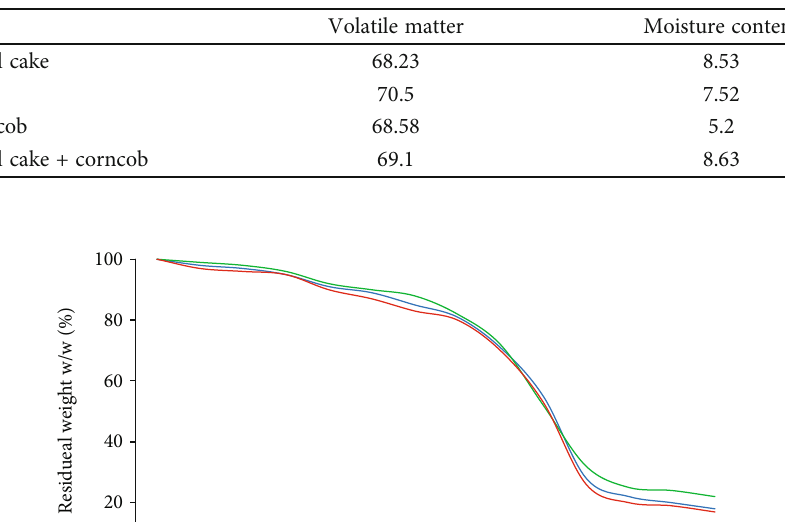
Table 4: Properties of blended feedstock.